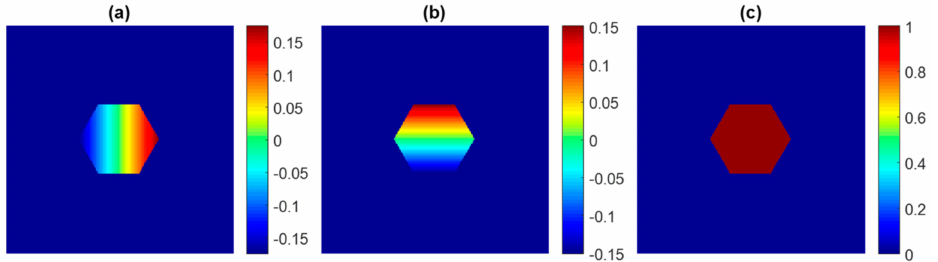
Figure 3. The basis for a single segment. ( a ) the base component on x-axis, ( b ) the base component on y-axis, ( c ) the base component on